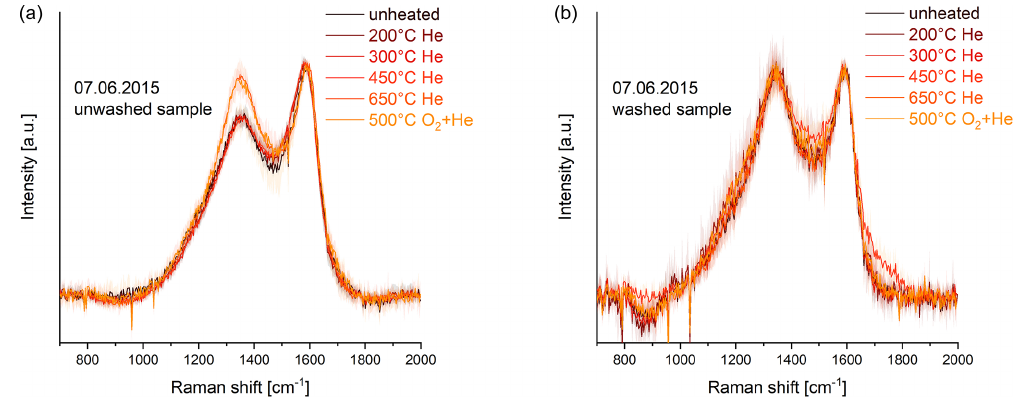
Figure 3. Progress of the Raman spectra during the heating procedure (EUSAAR2) of the washed (a) and unwashed (b) part of a represen- tative atmospheric aerosol sample (7 June 2015). Error bars are shown as shaded areas. The Raman spectra of the unwashed sample change at 650 ◦ C in He (late and fast change; see categorization below), while the spectra of the washed sample do not change noticeably during heating following